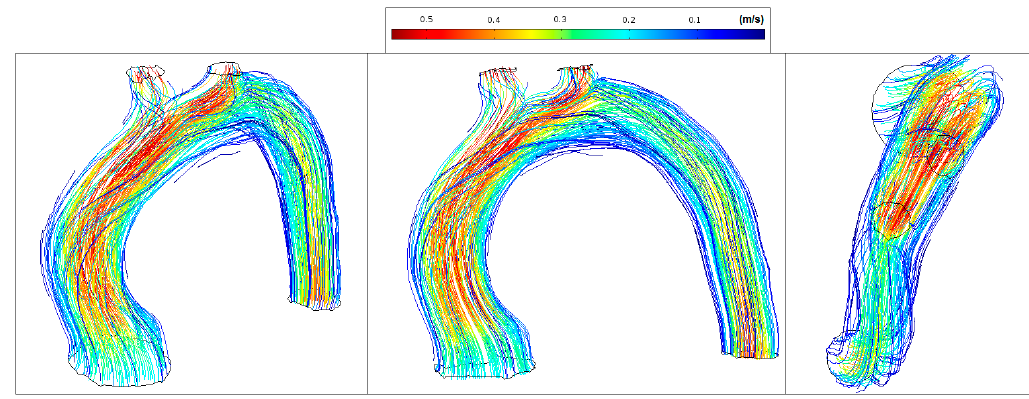
Figure 11. Healthy patient: velocity streamlines (peak systole).